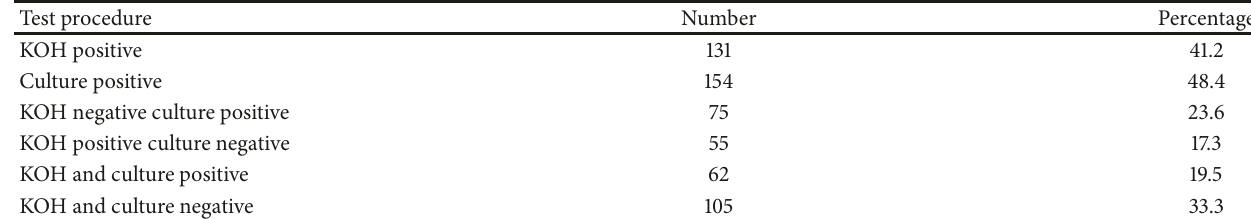
Table 2: Correlation of direct microscopy and culture (n= 318).